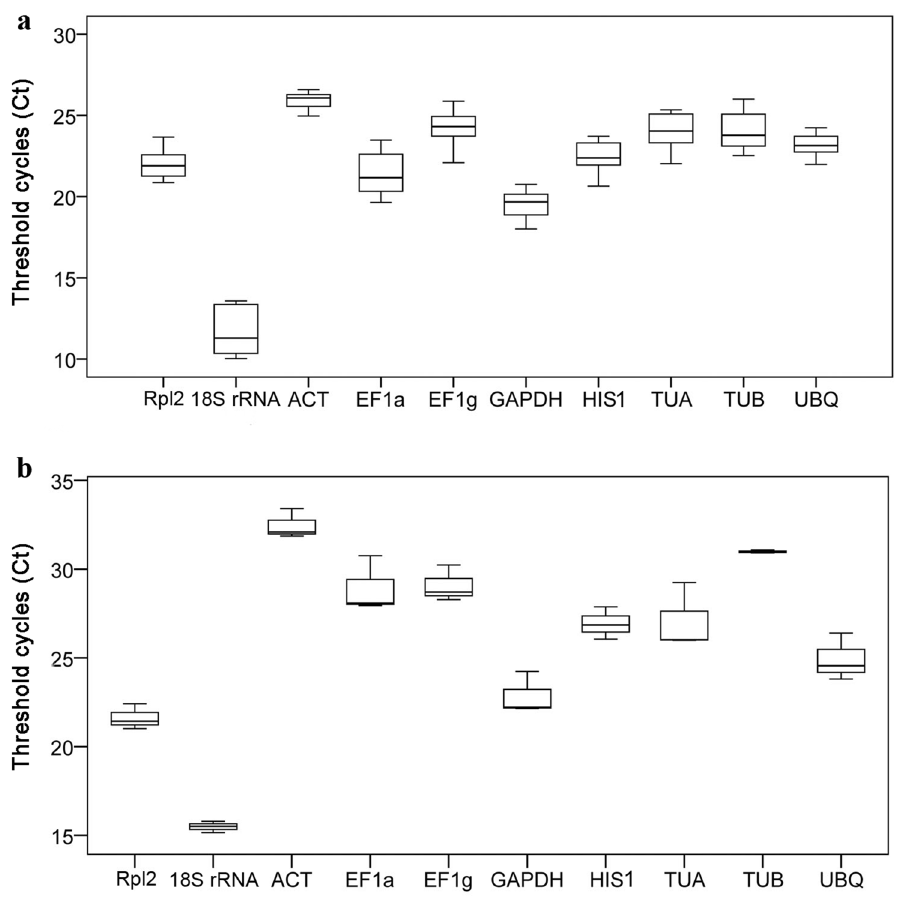
Figure 2. Expression levels of 10 reference genes in Liriodendron hybrids as determined by the quantification cycle values, also known as the threshold cycle (Ct) values, in the somatic embryogenesis ( a ) and the germination ( b ) groups. The boxes indicate the 25th and 75th percentiles, the line across each box represents the median, and whisker caps represent the maximum and minimum Ct values.